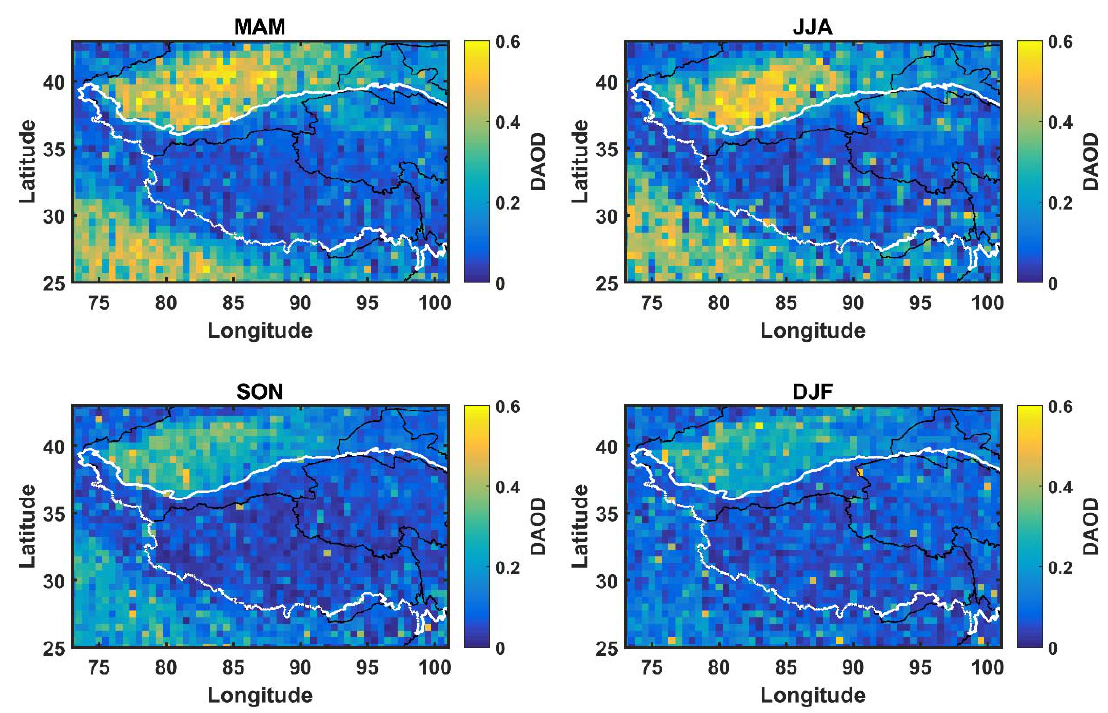
Figure 2. Seasonal distributions of DAOD during